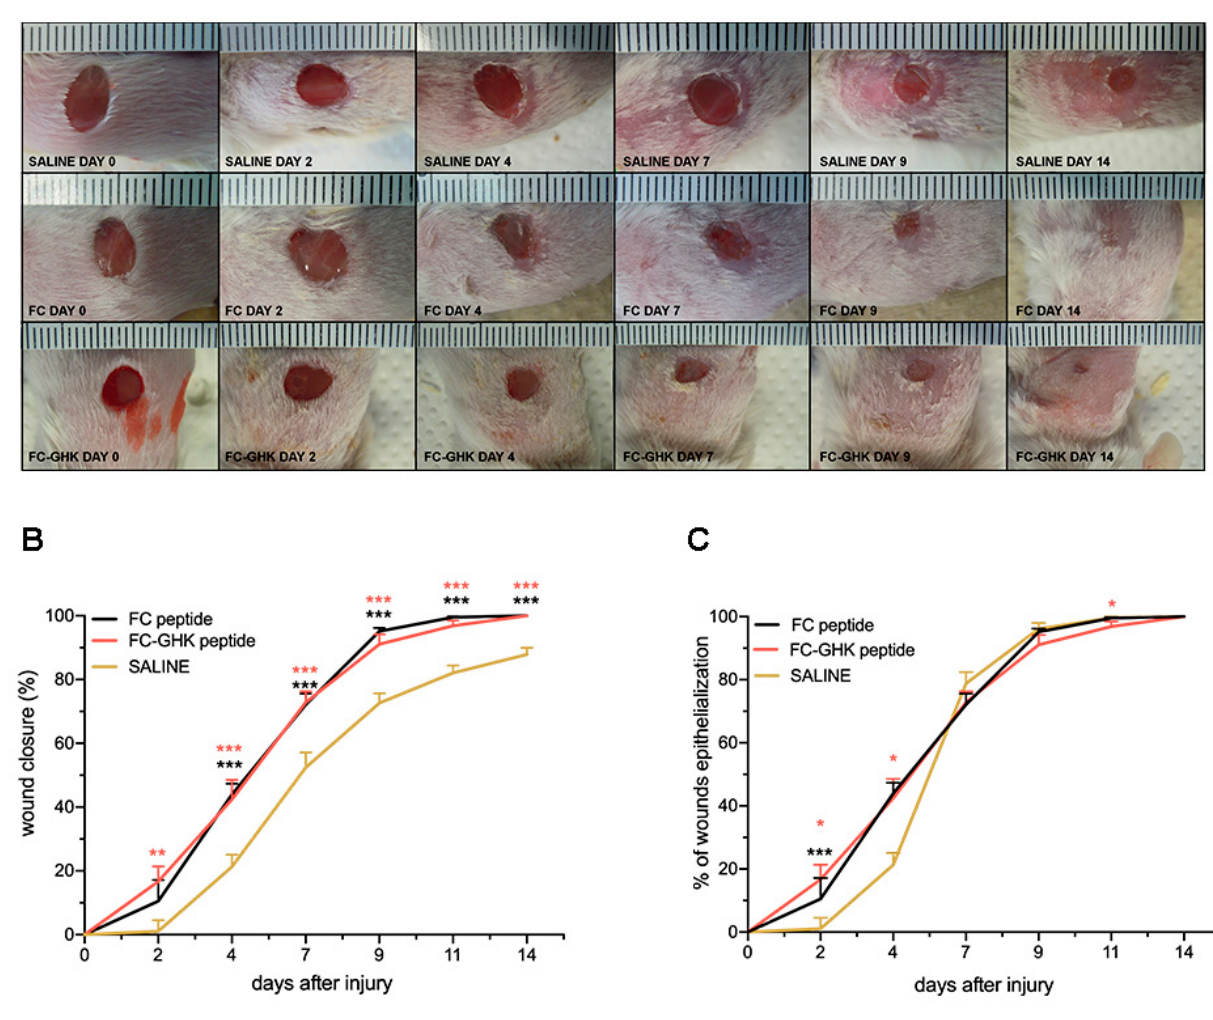
Figure 13. ( A ) Representative images of dorsal skin wounds in the control group and the non-fibrillated FC peptide and non-fibrillated FC-GHK peptide treatment groups. The images show wound healing progress from day 0 to day 14. ( B ) The relative area of dorsal skin injuries; ( C ) and wound epithelialization of the non-fibrillated FC and FC-GHK peptides compared to saline over time. The graph shows the average wound area relative to the initial wound surface, and error bars represent SEM. The number of wounds n = 12, representing six animals from both treatment groups and the control group. Statistical significance was determined with the Mann-Whitney U test; one (*), two (**), or three asterisks (***) indicate p < 0.05, p < 0.01, or p < 0.001, respectively.